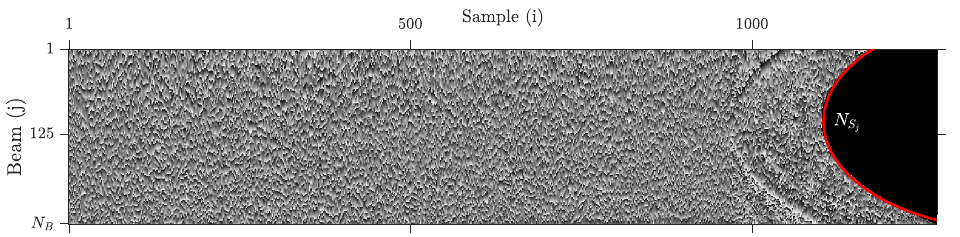
Figure 7. Raw representation of MWC phase data from an EM2040